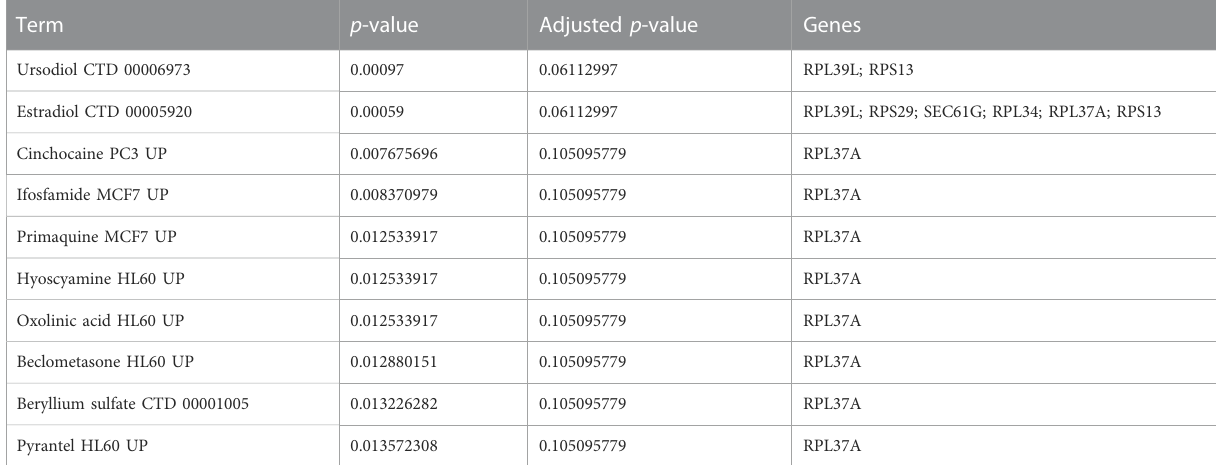
TABLE 2 Suggested top drug compounds for the RA.